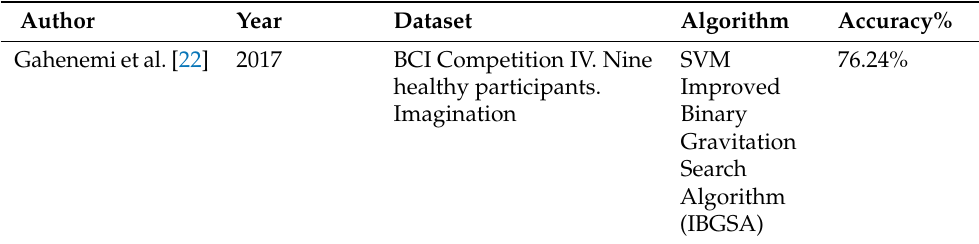
Table 3. EEG classification with ML